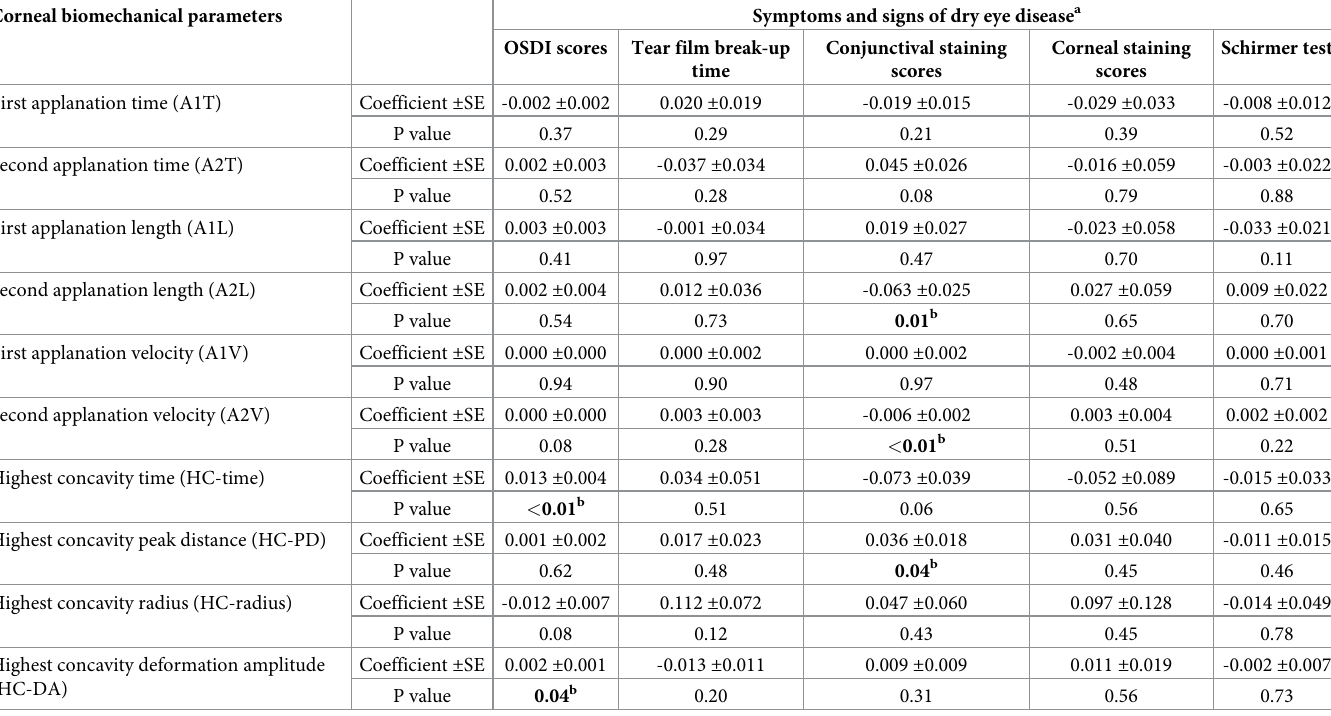
Table 4. The associations between symptoms and signs of dry eye disease and corneal biomechanical parameters in the low tear production group. Corneal biomechanical